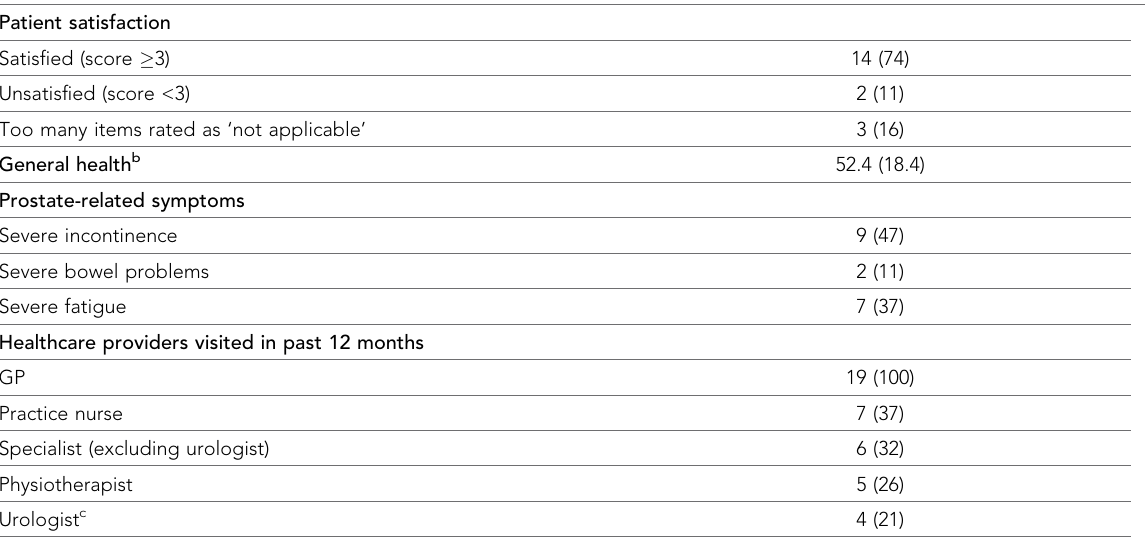
Table 2: Outcome after 12 months ( n = 19) a